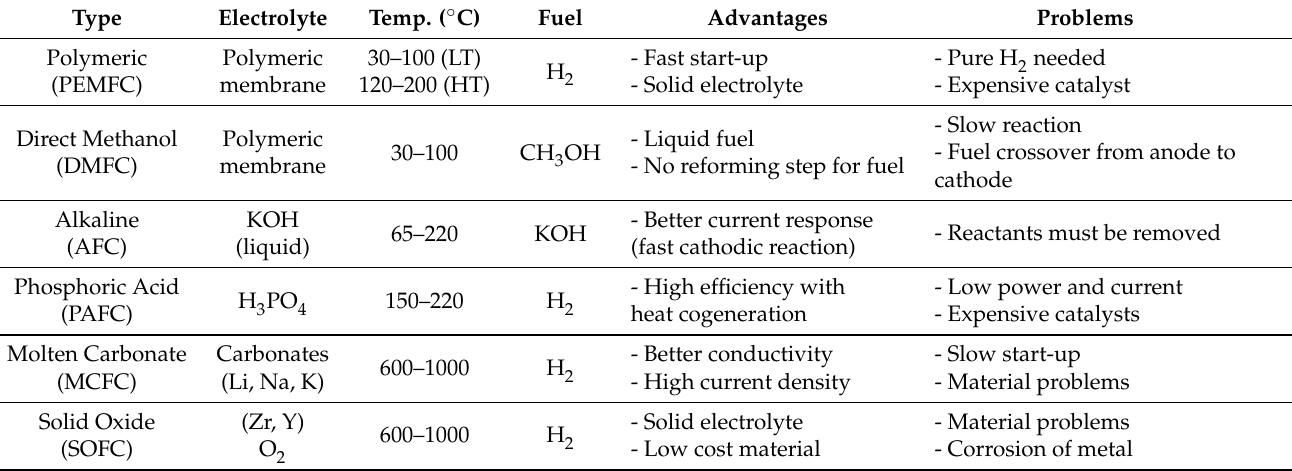
Table 1. Fuel cell technologies and their characteristics.